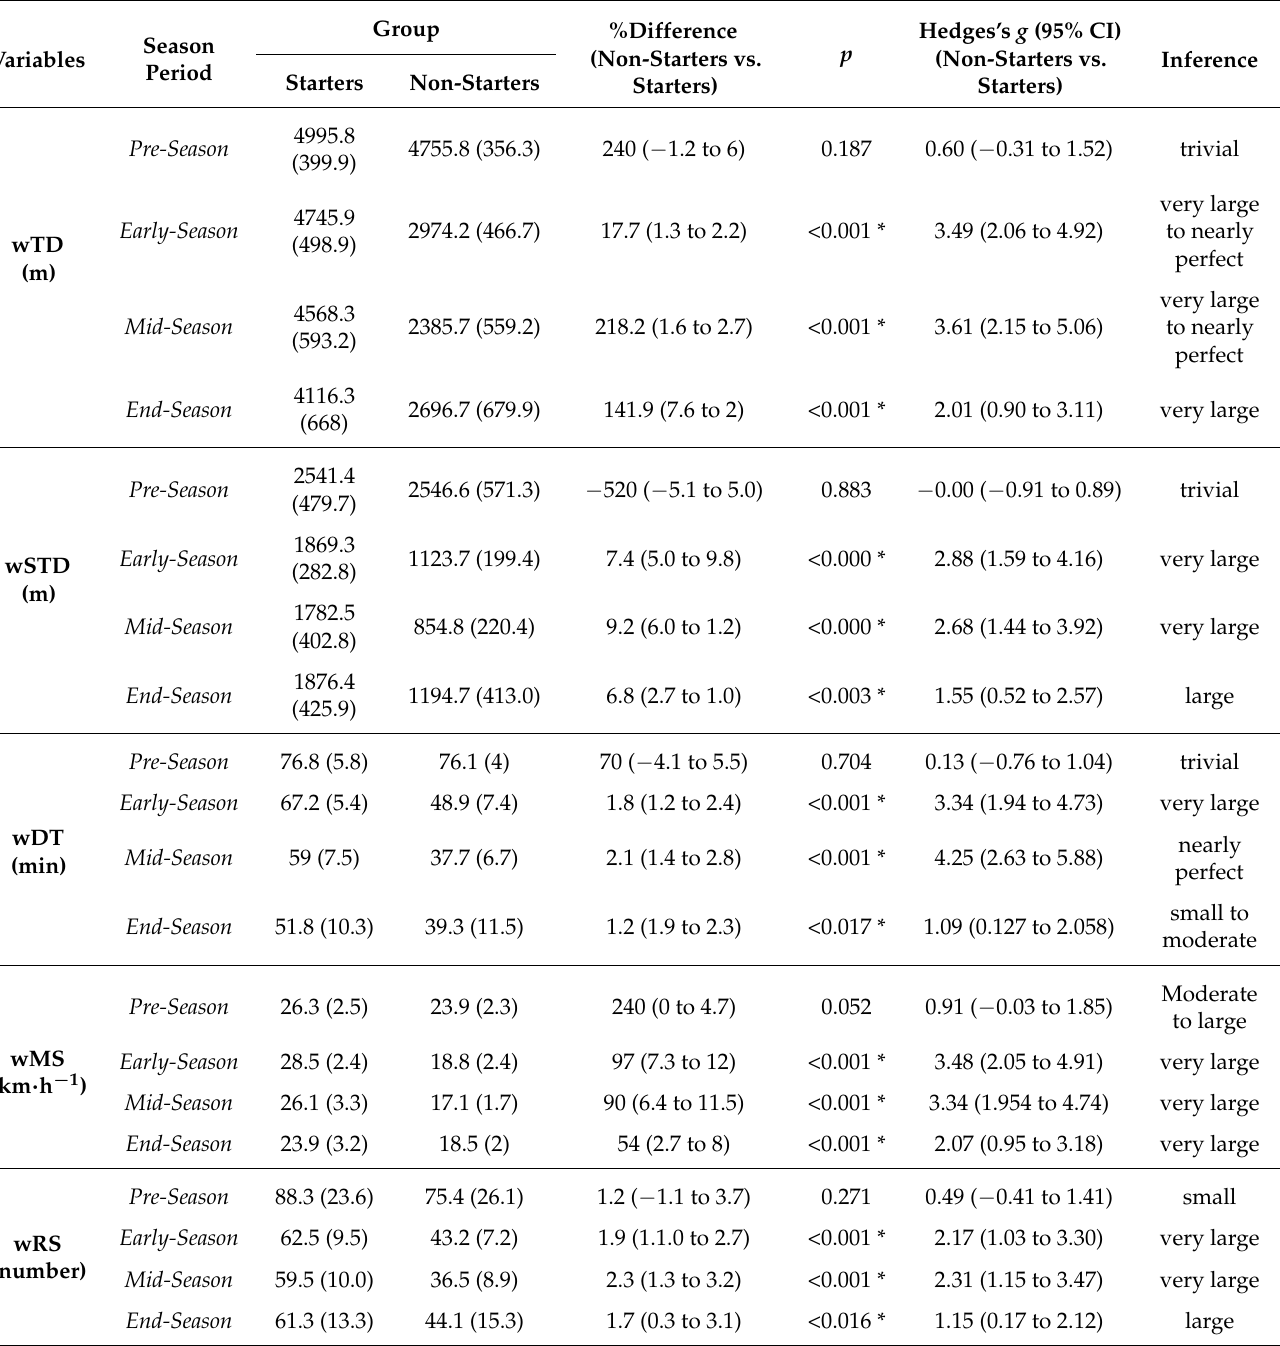
Table 2. Differences between starters and non-starters for derived GPS variables of distance and sprint in the different periods of the